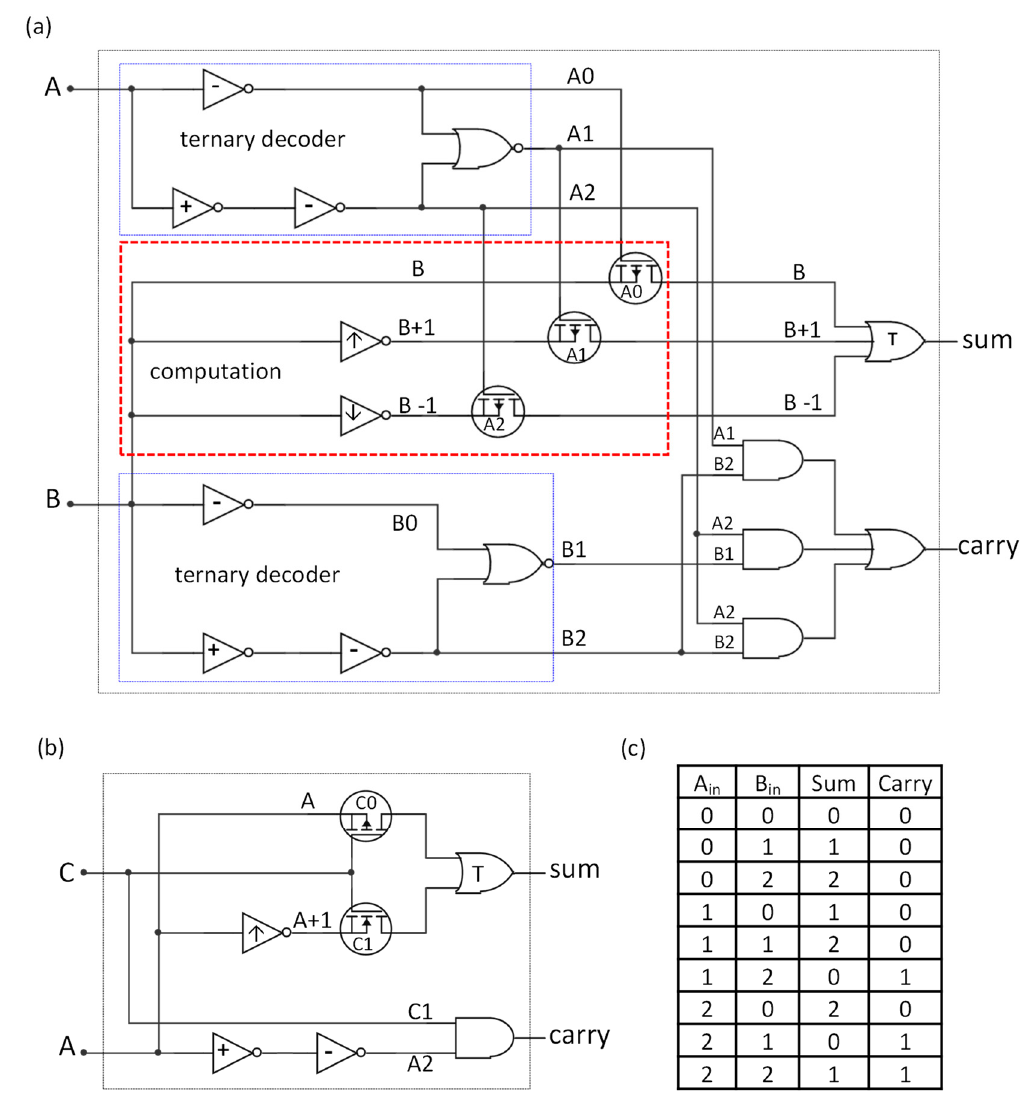
Figure 6. ( a ) Ternary half-adder Design 1, with the cycling DCI gate as the computation part. ( b ) Ternary half-adder Design 2, with the improved ternary adder algorithm, that the carry of the ternary adder can only be logic “0” or logic “1”. ( c ) Truth tables of the half adder.